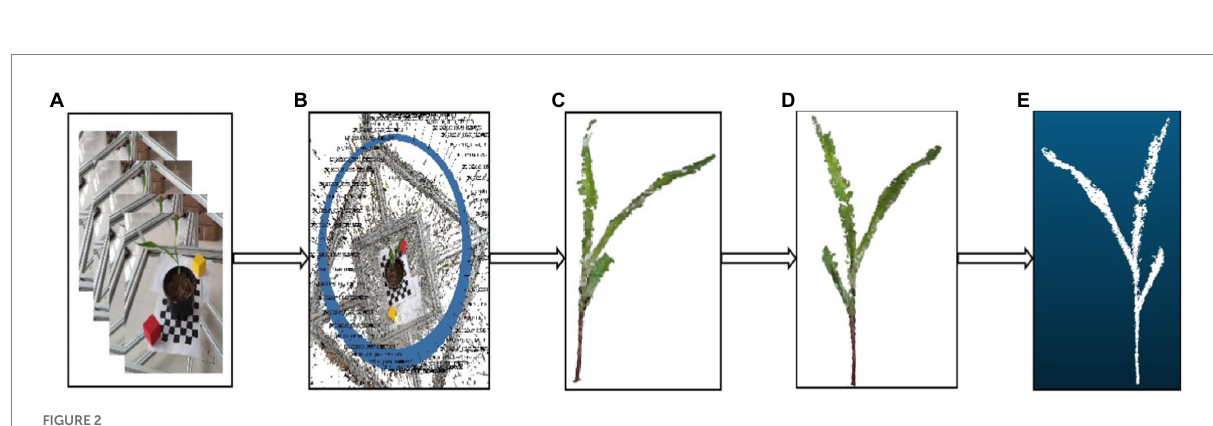
FIGURE 2 Point cloud algorithm process flow